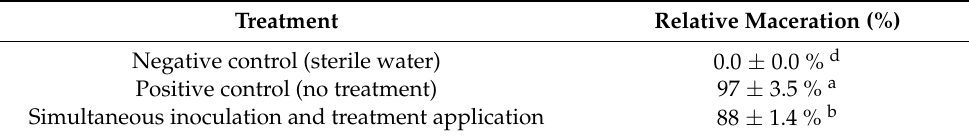
Figure 2. Ex situ inhibitory activity of aqueous ammonia leaf extract of T. baccata against Pectobacterium carotovorum subsp. carotovorum strain CITA Ecc-8 artificially inoculated on potato tuber slices: ( a ) negative control (sterile water); ( b ) positive control (pathogen and no treatment); ( c ) simultaneous inoculation of the pathogen and application of the extract; ( d ) inoculation of the pathogen and subsequent application of the extract after 2 h; and ( e ) application of the extract and subsequent inoculation of the pathogen after 2 h. Table 4. Percentage of maceration of potato slices artificially inoculated with Pectobacterium caro- tovorum subsp. carotovorum strain CITA Ecc-8 as a function of T. baccata leaf extract (187.5 µ g · mL − 1 ) treatment application